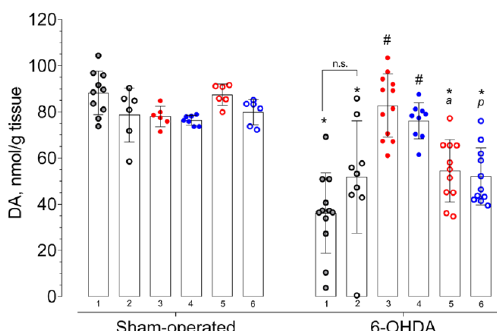
Figure 1. Influence of deferred administration of afobazole over 14 days on dopamine content in 6-hydroxidodamine (6-OHDA)-lesioned ICR mice striata. Data are presented as mean ± S.D.